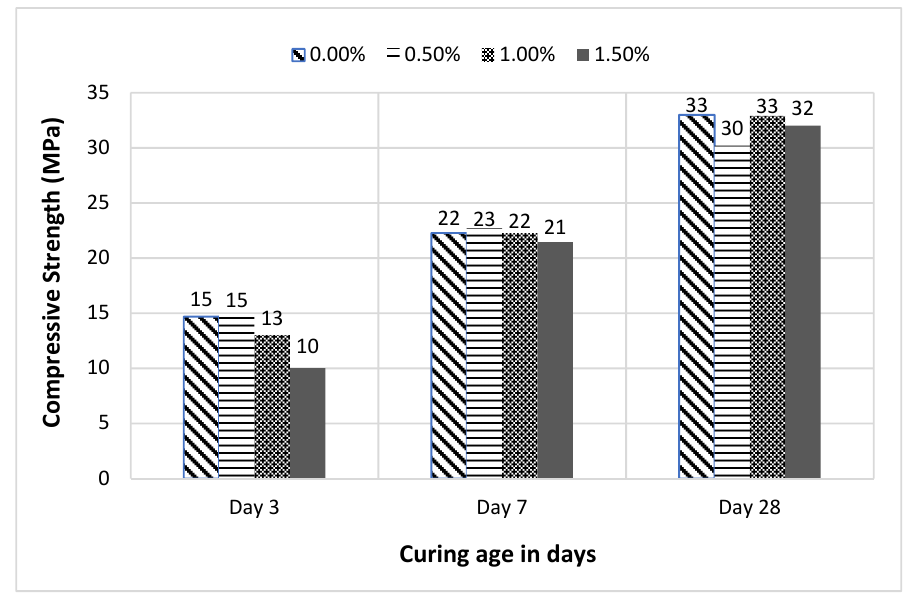
Figure 4. The effect of adding PA fibers on the compressive strength of concrete mixes at 3, 7, and 28 days of curing. Table 3. Quality of concrete based on UPV value (ASTM C597